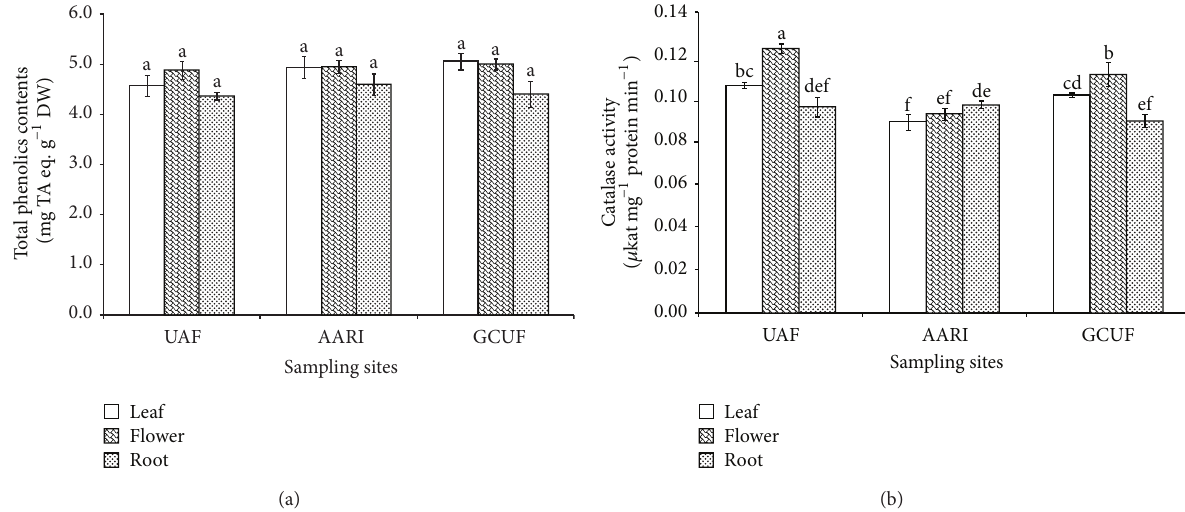
Figure 5: Total phenolics (a) and catalase activity (b) in different tissues of calendula plants collected from semi-arid zone. Values ( 𝑛 = 9± SE) with different superscripts (a–f) are significantly different at 𝑃 < 0.05 . GA eq.: gallic acid